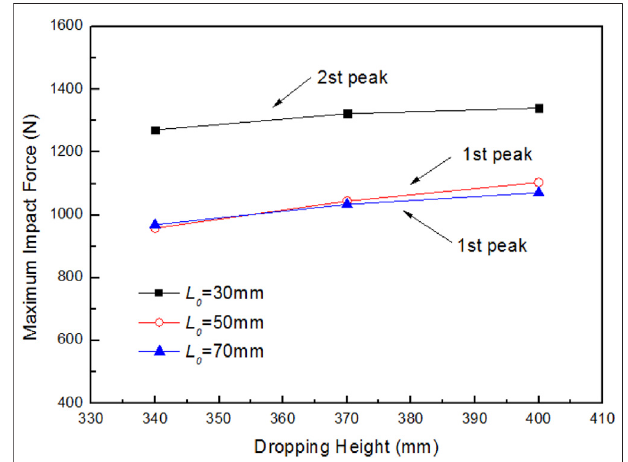
FIGURE 16 | The effects of dropping height on the maximum impact force under different piston stroke.